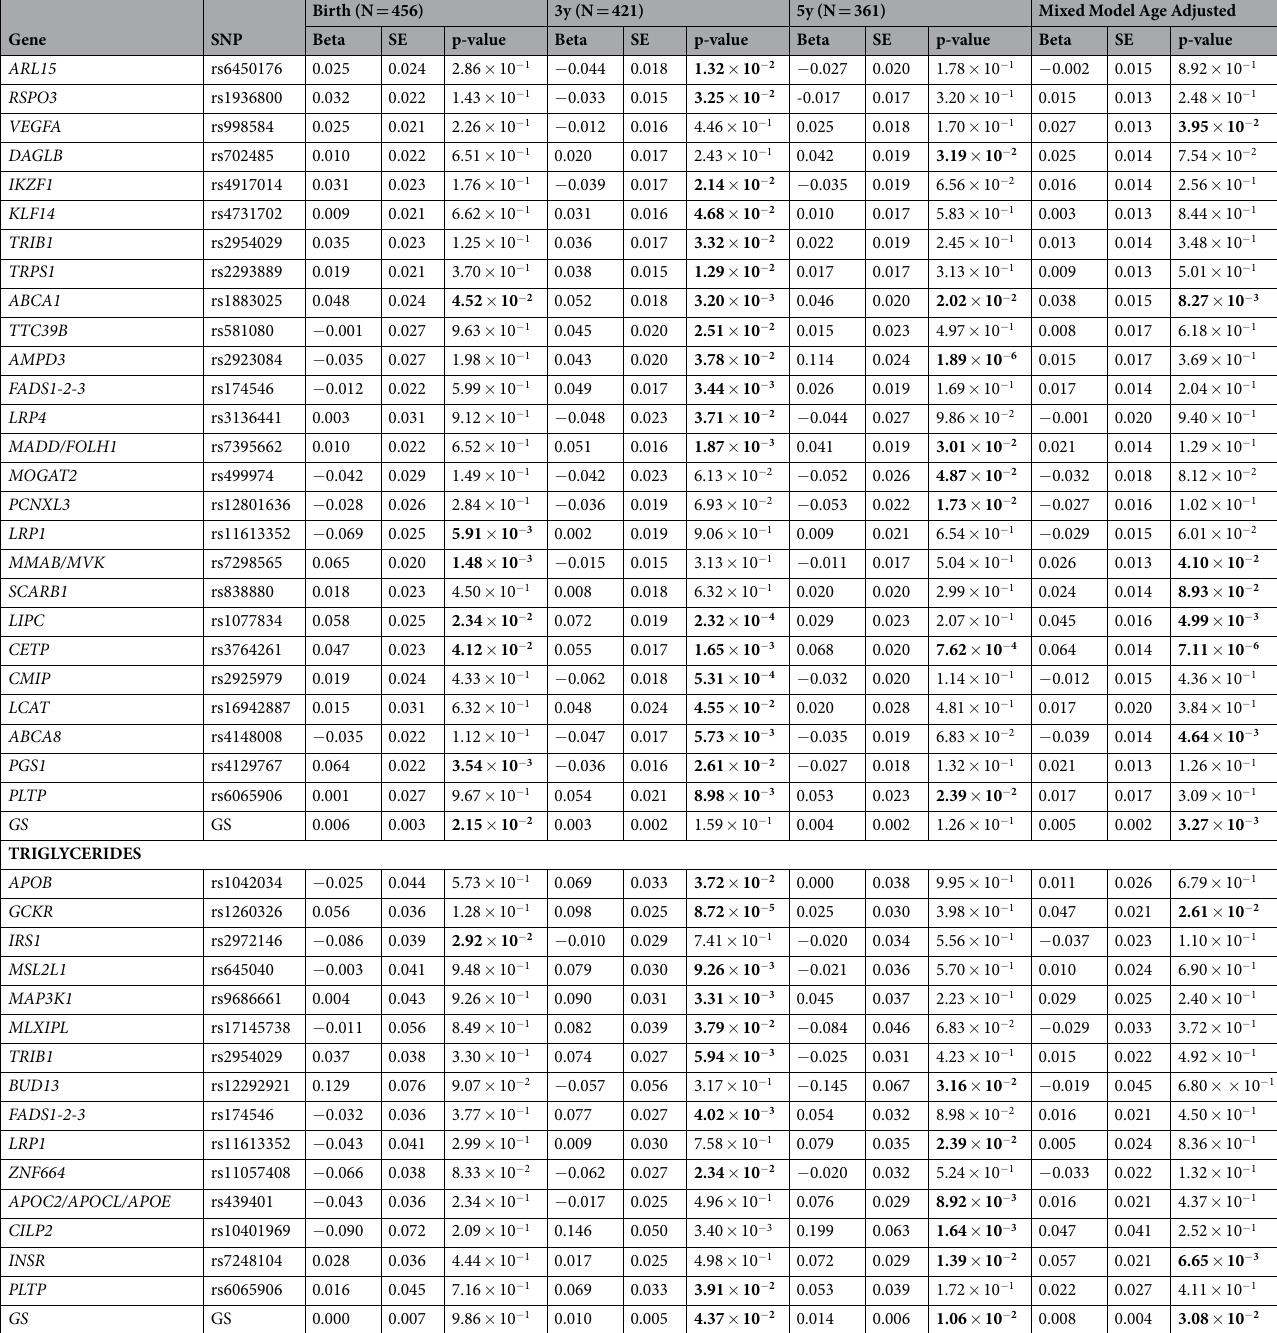
Table 3. Summary results for statistically nominal and significant associations between SNPs and lipids. Beta and SE at birth, 3 year and 5 year are natural logarithm of the lipid level trait in mg/dl. The unit of beta and SE after linear mixed model is natural logarithm of the lipid level trait in mg/dl per